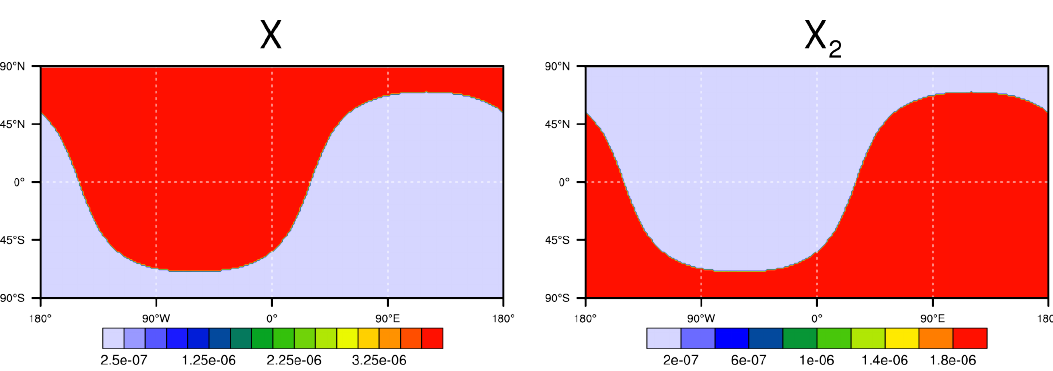
Figure 2. Contour plots of the steady-state solutions, assuming no flow, for X (left) and X 2 (right), respectively, computed from initial conditions X = 4 . 0 × 10 − 6 and X 2 =